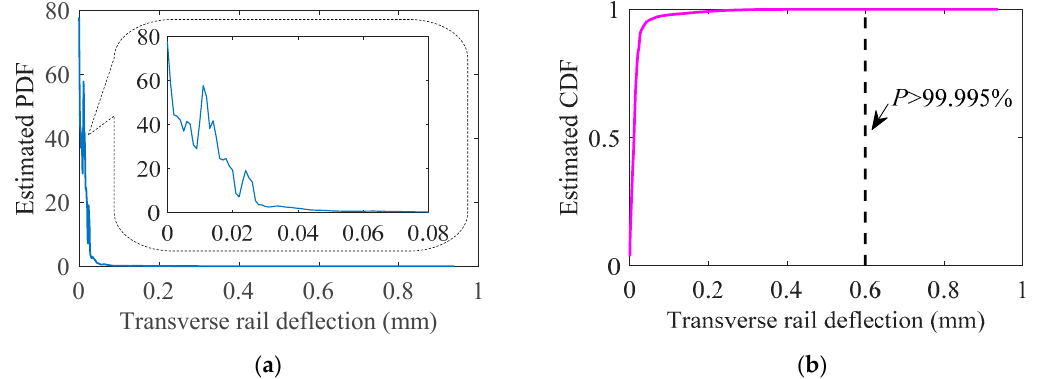
Figure 15. Statistical features of transverse rail deflections based on the kernel density estimation: ( a ) PDF; ( b ) cumulative distribution function (CDF).